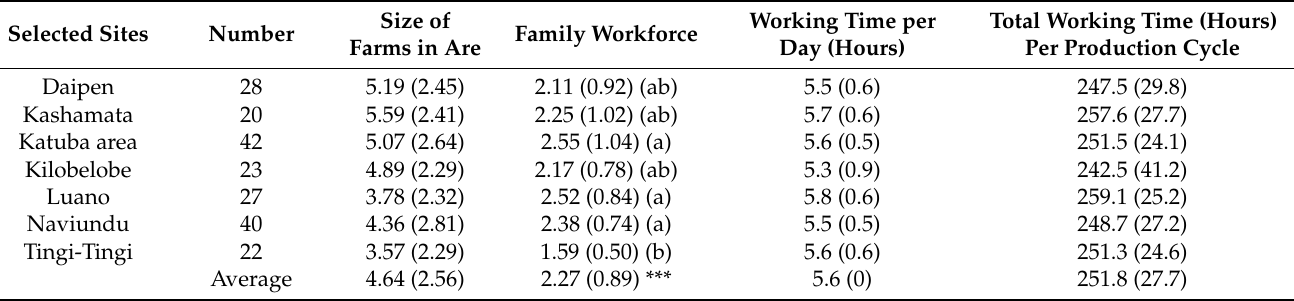
Table 6. Farm size and permanent